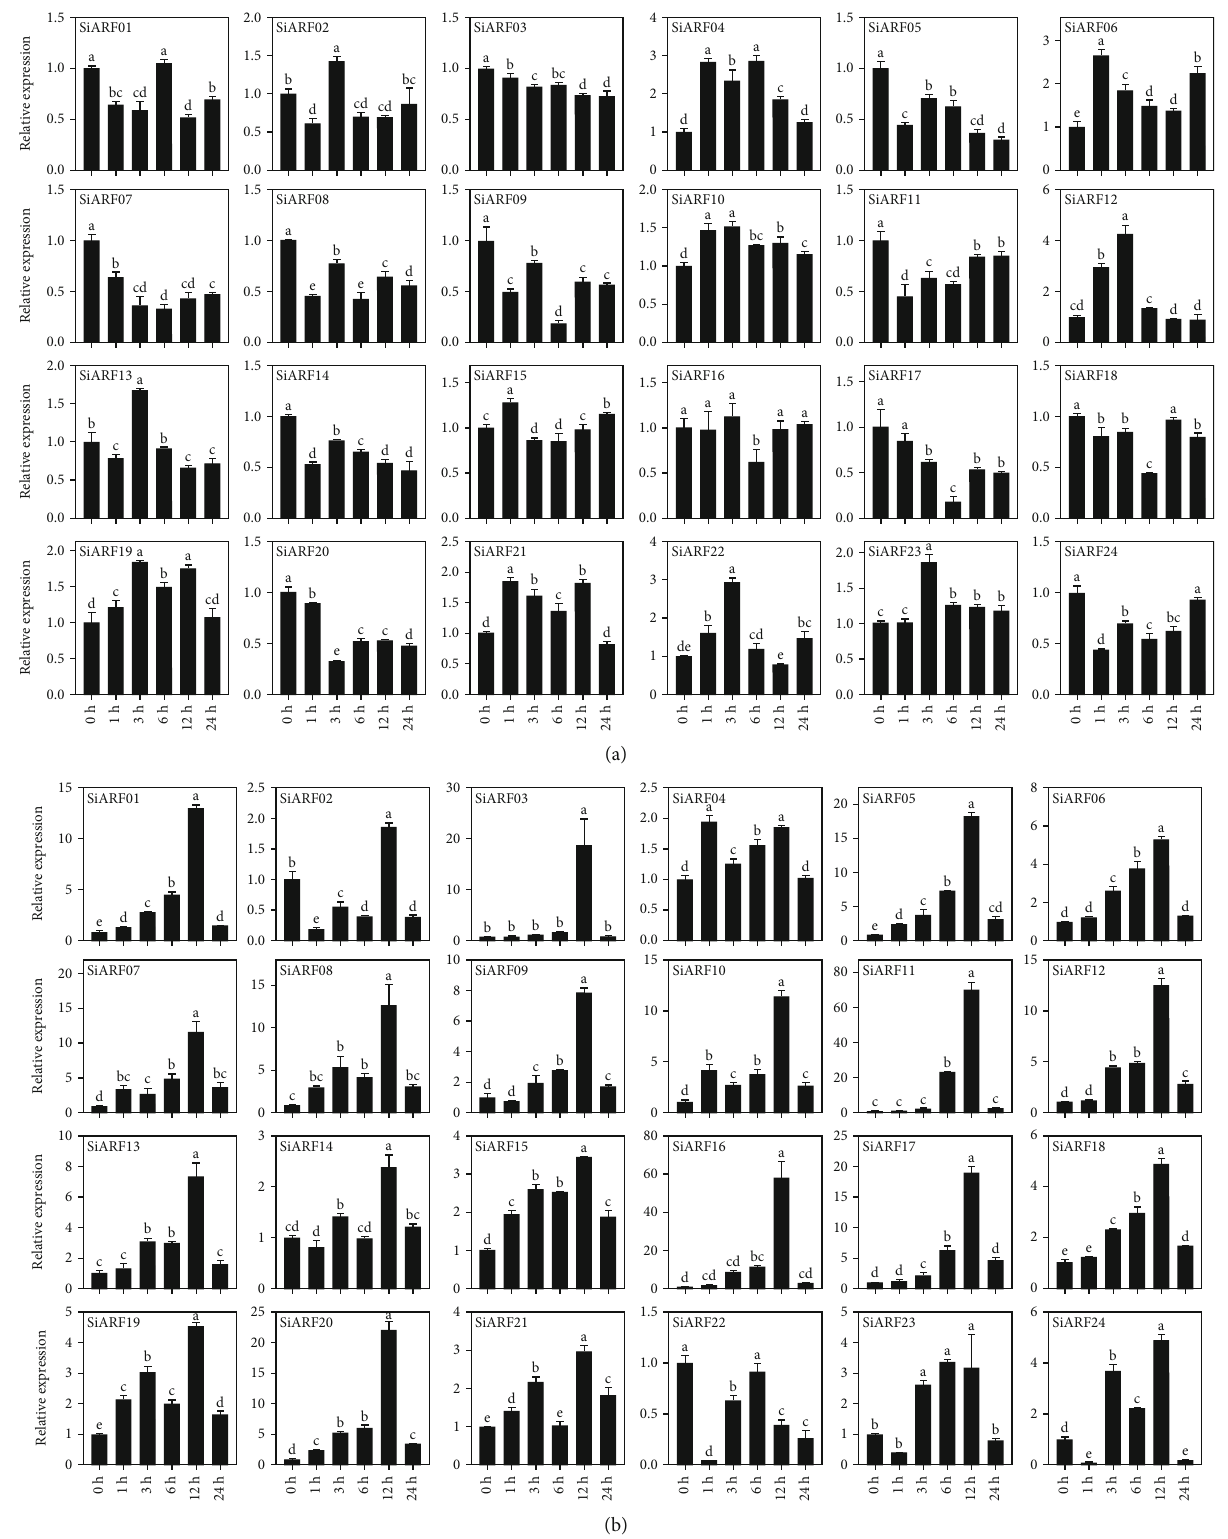
Figure 7: The relative expression of 24 SiARFs analyzed using real-time quantitative PCR under (a) indole-3 ′ -acetic acid (IAA) treatment and (b) abscisic acid (ABA) treatment after 0 h, 1 h, 3 h, 6 h, 12 h, and 24 h. All the experimental results were based on three biologic replicates. Error bars imply ± SD for three biological replicates. Di ff erent letters indicate signi fi cant di ff erences ( p < 0 : 05